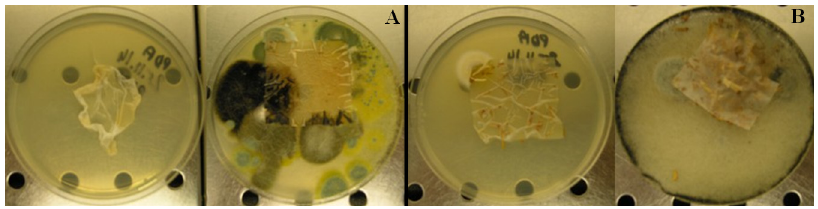
Figure 5. Isolates obtained after 7 days at 22.5°C from samples taken on FWAS‐S0% (A) and FWAS‐S3% (B) specimens. Sampling was performed on the surface of (on the left) and inside (on the right) each specimen.